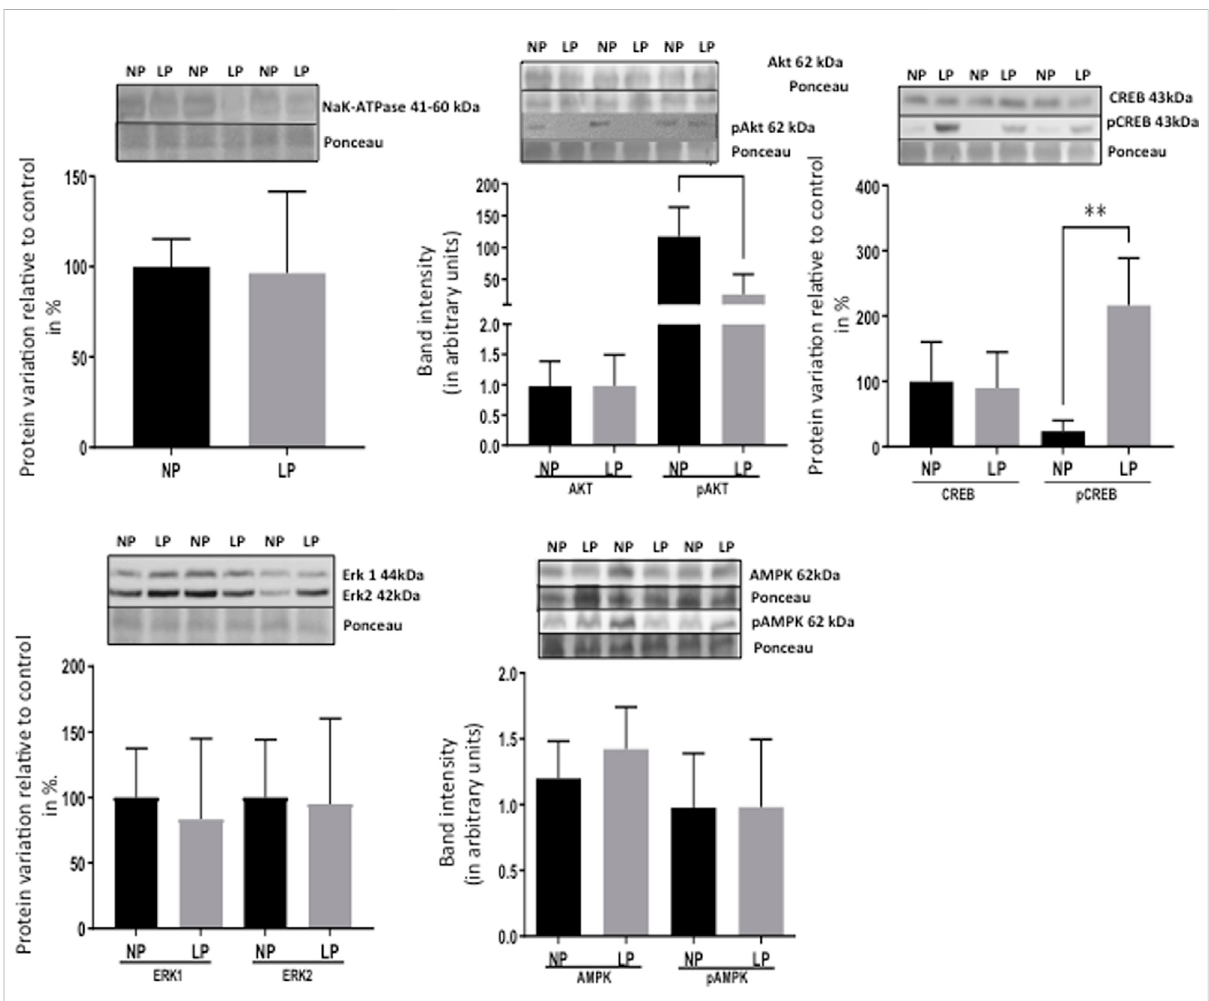
FIGURE 8 Effect of maternal protein restriction on ERK 1/2, Na-K ATPase, AKT, pAKT, CREB, pCREB, AMPk, and pAMPk proteins, measured using immunoblotting analysis in the isolated LV. The statistical analysis was performed by Student ’ s t-test when comparing only two samples of independent observations;onlyoneoffspringofeachlitterwasusedfor immunoblotting experiments.Theproteinvariation resultsfromLPprogeny were expressed as mean ± SD and relative to control (NP offspring), assigning a value in %. *p < 0.05; **p <